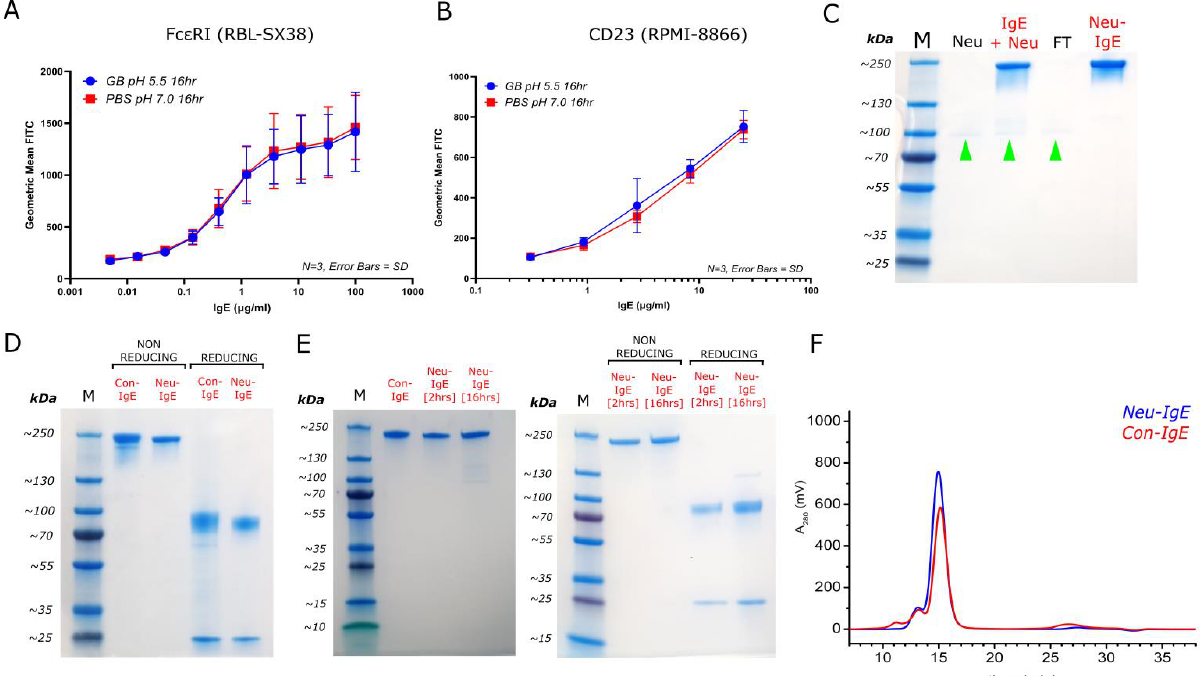
Figure 2. Small-scale generation of sialic acid-deficient CSPG4-IgE ( A ). Effects of enzyme incubation conditions on IgE binding activity to Fc ε RI on RBL-SX38 cells. GB = GlycoBuffer 1, pH 5.5; PBS = PBS, pH 7.0. N = 3, error bars = SD; ( B ). Effects of enzyme incubation conditions on IgE binding activity to CD23 on RPMI-8866 cells. GB = GlycoBuffer 1, pH 5.5; PBS = PBS, pH 7. N = 3, error bars = SD; ( C ). InstantBlue-stained SDS-PAGE to confirm purification of Neu-IgE via IgE class-specific affinity chromatography M, molecular marker; Neu, Neuraminidase-only control sample; IgE+ Neu, post-neuraminidase incubation sample containing CSPG4-specific IgE + neuraminidase; FT, affinity chromatography flowthrough sample; Neu-IgE, neuraminidase-treated IgE post-purification. Green arrows indicate location of neuraminidase; ( D ). InstantBlue-stained SDS-PAGE comparing Con-IgE and Neu-IgE under non-reducing and reducing conditions; ( E ). InstantBlue-stained SDS- PAGE showing Neu-IgE incubated at either 2 h or 16 h in comparison to Con-IgE under non-reduc- ing conditions and comparing Neu-IgE (2 h) vs. Neu-IgE (16 h) under non-reducing and reducing conditions; ( F ). SEC analysis of Neu-IgE (blue) in comparison with unmodified (native) CSPG4-IgE (Con-IgE, red) both purified via IgE class-specific affinity chromatography.